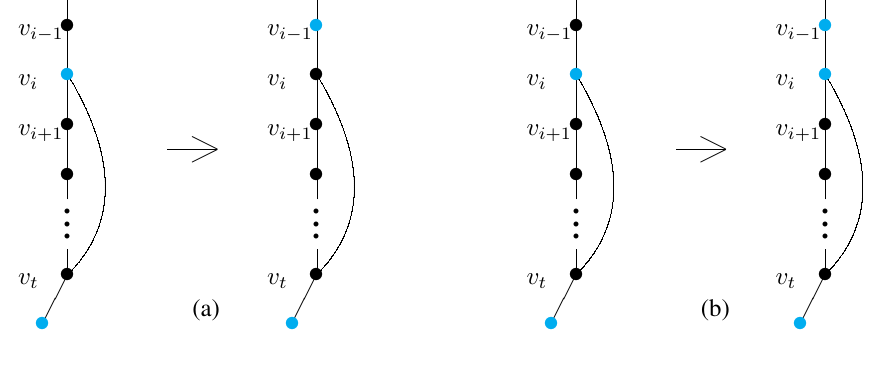
Fig. 4: Recolourings in Subcase